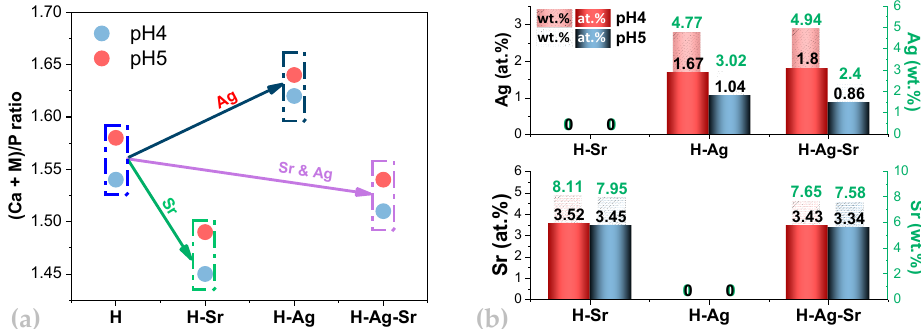
Figure 3. Evolution of (Ca + M)/P ratio ( a ) and doping element concentration (Ag, Sr and Ag & Sr) in each coating expressed in at.% and wt.% ( b ).